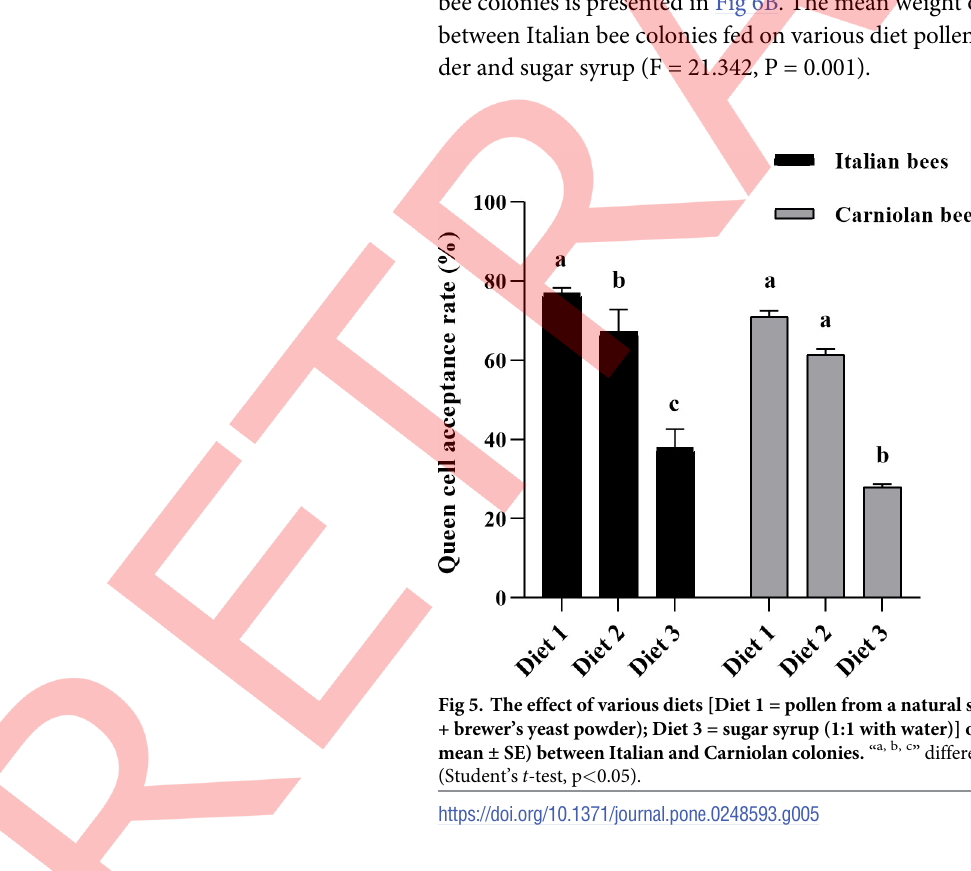
Fig 5. The effect of various diets [Diet 1 = pollen from a natural source; Diet 2 = pollen substitutes (soybean flour + brewer’s yeast powder); Diet 3 = sugar syrup (1:1 with water)] on the queen cell acceptance rate (shows as mean ± SE) between Italian and Carniolan colonies. “ a, b, c ” different letter represents significant mean differences (Student’s t -test, p <